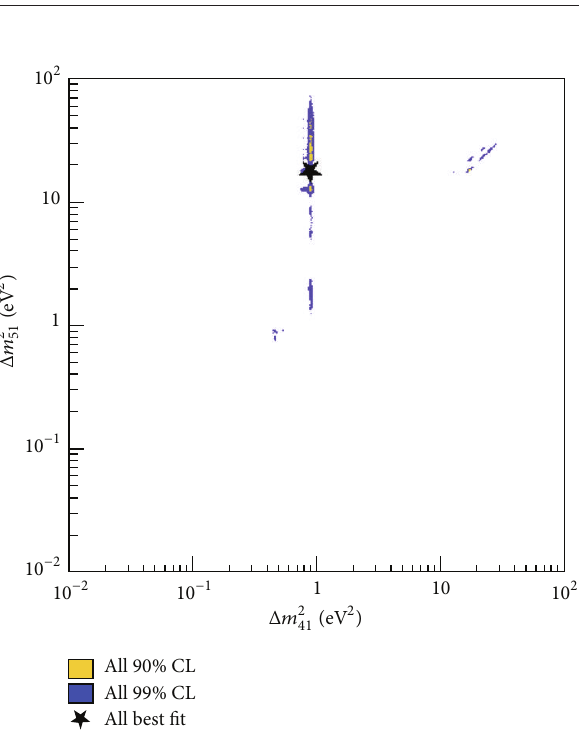
Figure 16: The 3 + 2 best fit Δ𝑚 2 41 versus Δ𝑚 2 51 values from [10].